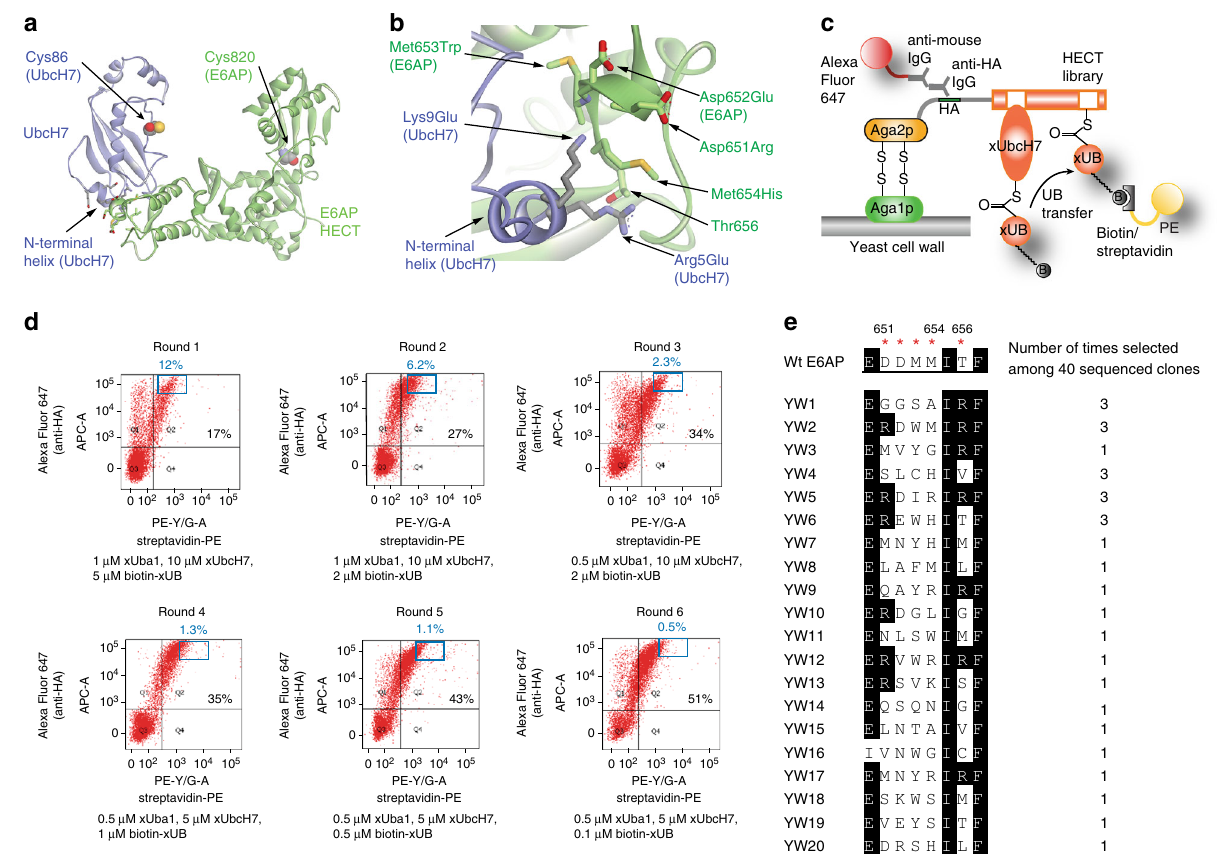
Fig. 2 Yeast selection of E6AP library to engineer the xUbcH7-xE6AP pair. a Crystal structure of the E6AP HECT domain in complex with UbcH7 (PDB ID 1C4Z) 22 . The N-terminal helix of UbcH7 plays a key role in interacting with the HECT domain. The catalytic Cys residues in UbcH7 and the E6AP HECT are shown in CPK models. b Detailed interactions between the N-terminal helix of UbcH7 and the HECT domain of E6AP. To complement the R5E and K9E mutations in xUbcH7, D651, D652, M653, M654 and T656 in the HECT domain of E6AP were randomized for library selection by yeast cell surface display. HECT mutant YW6 with mutations D651R, D652E, M653W, and M654H was selected and used as xHECT in this study. c Yeast cell surface display of the HECT domain of E6AP and selection of the HECT library based on the transfer of biotin-xUB from xUbcH7 to the HECT domain. Biotin-xUB attached to HECT was labeled with streptavidin-PE, and the HA tag fused to the N-terminus of the HECT domain was labeled with a mouse anti-HA antibody and an anti-mouse IgG conjugated with Alexa 647. d FACS sorting of the HECT library of E6AP to select for yeast cells (EBY100) doubly labeled with PE and Alexa 647 as indicators of biotin-xUB conjugation and display of HECT on the cell surface, respectively. The HECT library underwent six rounds of xUB loading, streptavidin and antibody labeling, and cell sorting. Percentages in black designate fraction of yeast cells doubly labeled with PE and Alexa 647. The frames and percentages in blue designate the fraction of yeast cells collected by FACS in each round of selection. e Sequence alignment of the E6AP HECT clones selected by yeast cell surface display. Residues denoted by red stars were randomized in the HECT